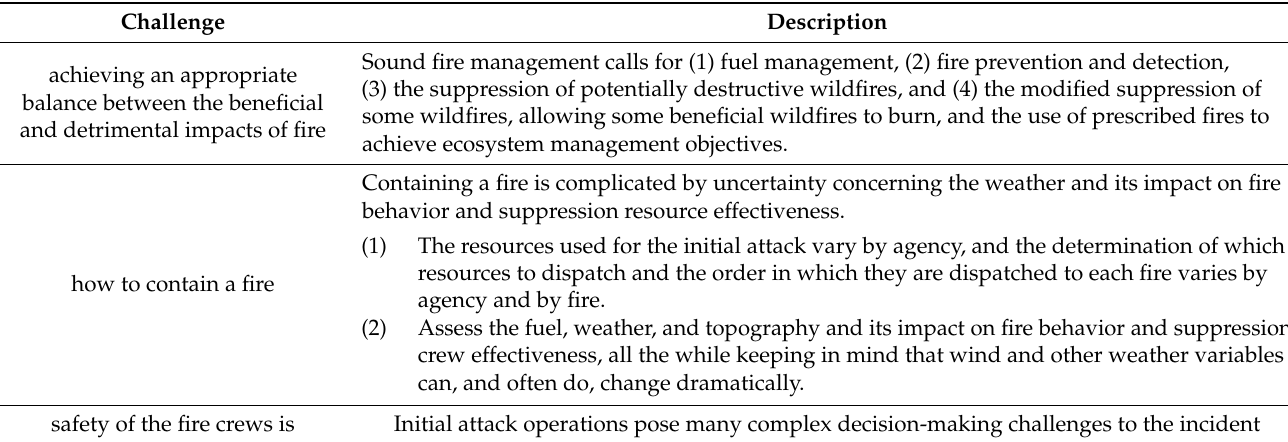
Table 4. Challenges for DSS in wildland fires according to Martell